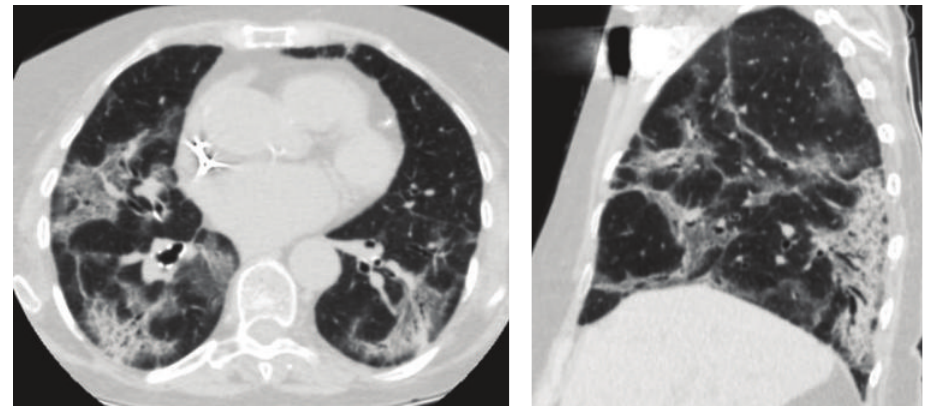
Figure 7: Drug induces lung changes with the use of amiodarone in an 81-year-old patient. Computed tomography shows the pattern of cryptogenic organizing